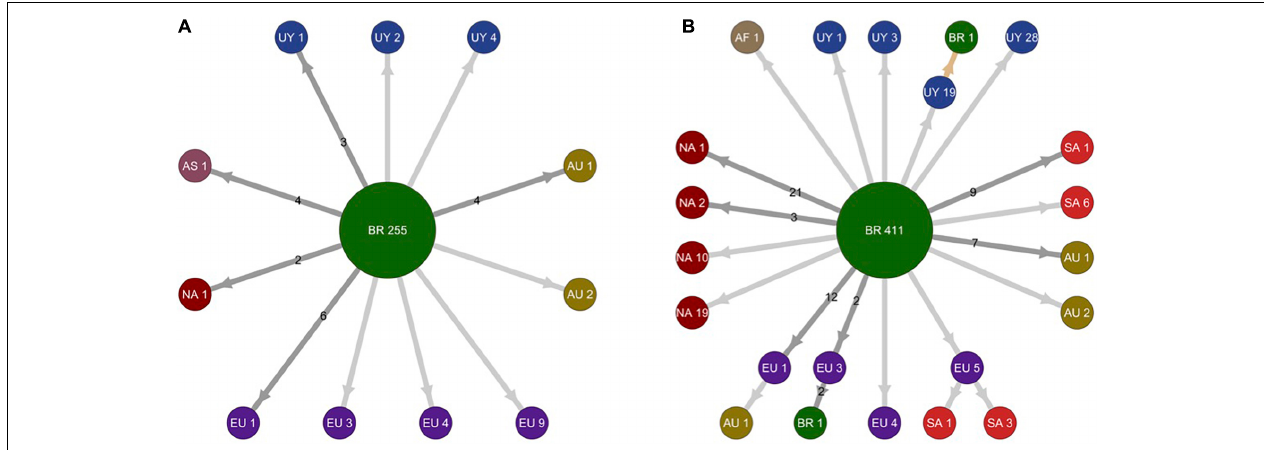
FIGURE 3 | Schematic representation of migration events during worldwide dissemination of SARS-CoV-2 lineages B.1.1.28 and B.1.1.33. The picture depicts the migration events in SARS-CoV-2 lineages B.1.1.28 (A) ( n = 298 sequences) and B.1.1.33 (B) ( n = 578 sequences) inferred by ancestral character reconstruction obtained through a maximum likelihood (ML) method implemented in PastML. Each node in the network is identified by location and number of sequences within different phylogenetic subclusters. Arrows indicate migration events deduced from location state changes across both trees (B.1.1.28 and B.1.1.33). Dark gray arrows identify multiple migration events and numbers in the arrows quantify the number of migration events connecting respective locations. Light gray arrows identify unique migration events. The light brown arrow points out to a single inferred migration event from Uruguay to Brazil. Nodes are colored according to their location. AF, Africa; AS, Asia; AU, Australia; BR, Brazil; EU, Europe; NA, North America; SA, South America; UY,